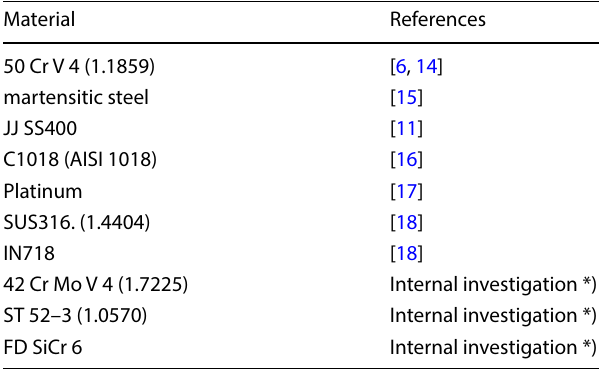
Table 3 The materials in the reviewed literature